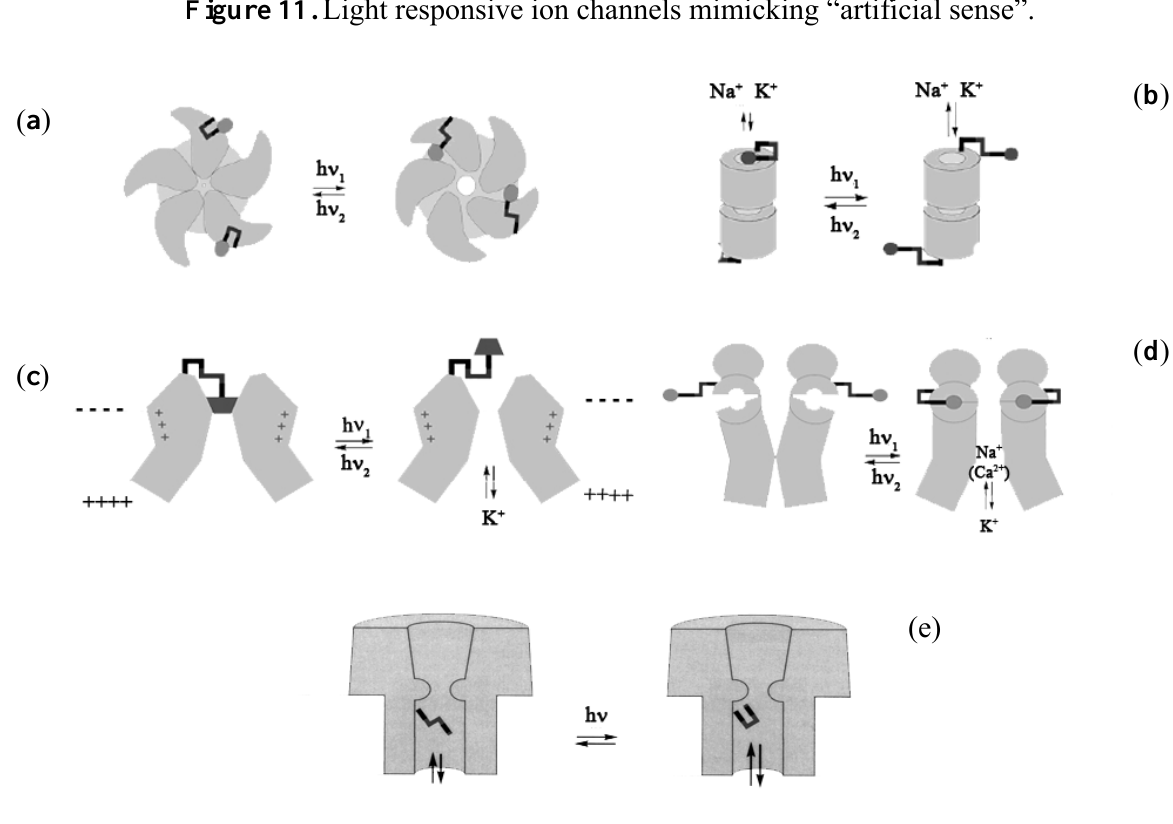
Figure 11. Light responsive ion channels mimicking “artificial sense”.